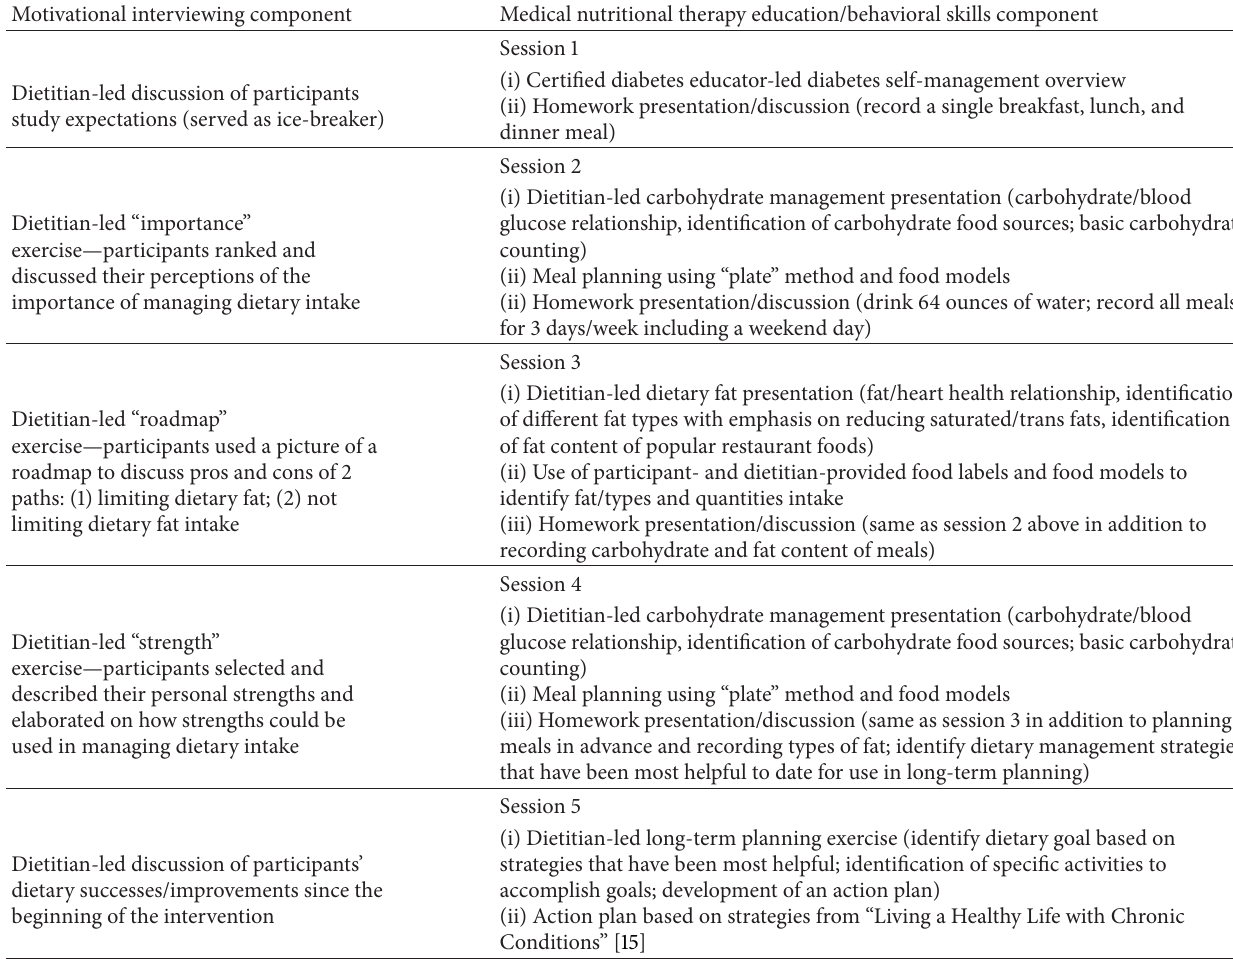
Table 1: Group medical nutrition therapy/motivational interviewing intervention among African American women with type 2